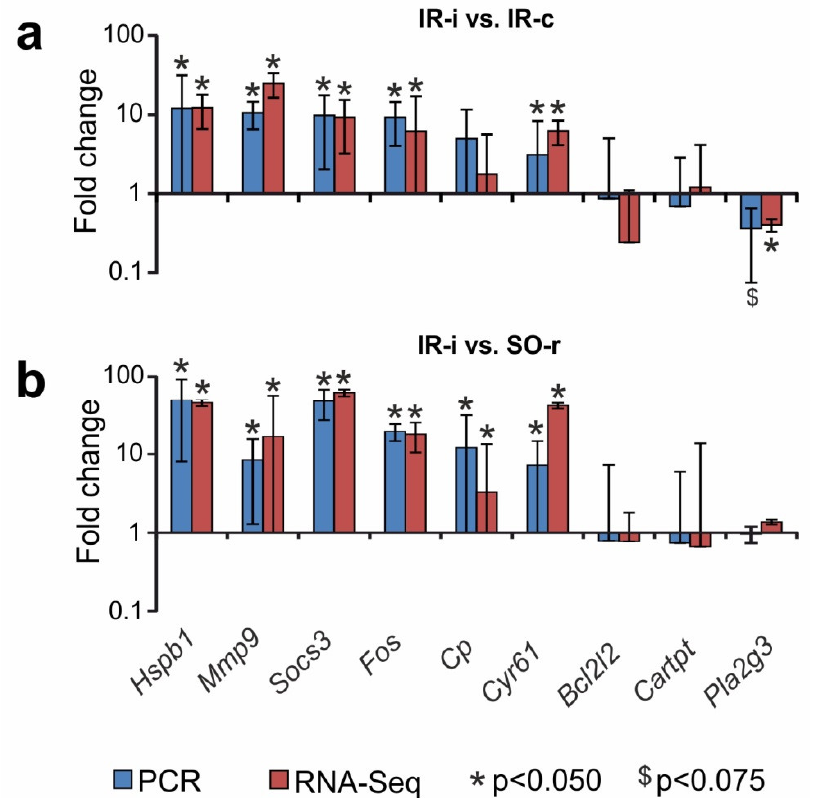
Figure 5. Real-time RT-PCR verification of the RNA-Seq results. Data for comparisons of IR-i vs. IR-c and IR-i vs. SO-r are shown. Nine ( Hspb1 , Mmp9 , Socs3 , Fos , Cp , Cyr61 , Bcl2l2 , Cartpt , and Pla2g3 ) genes were selected for PCR analysis. The reference Gapdh and Rpl3 genes were used to normalize the PCR results. Five animals were included in each comparison group.